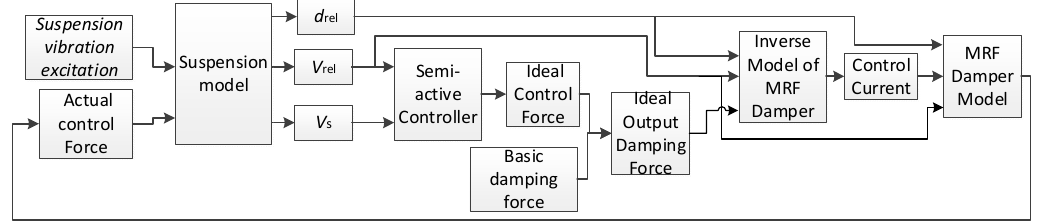
Figure 14. Control process of the semi-active suspension.